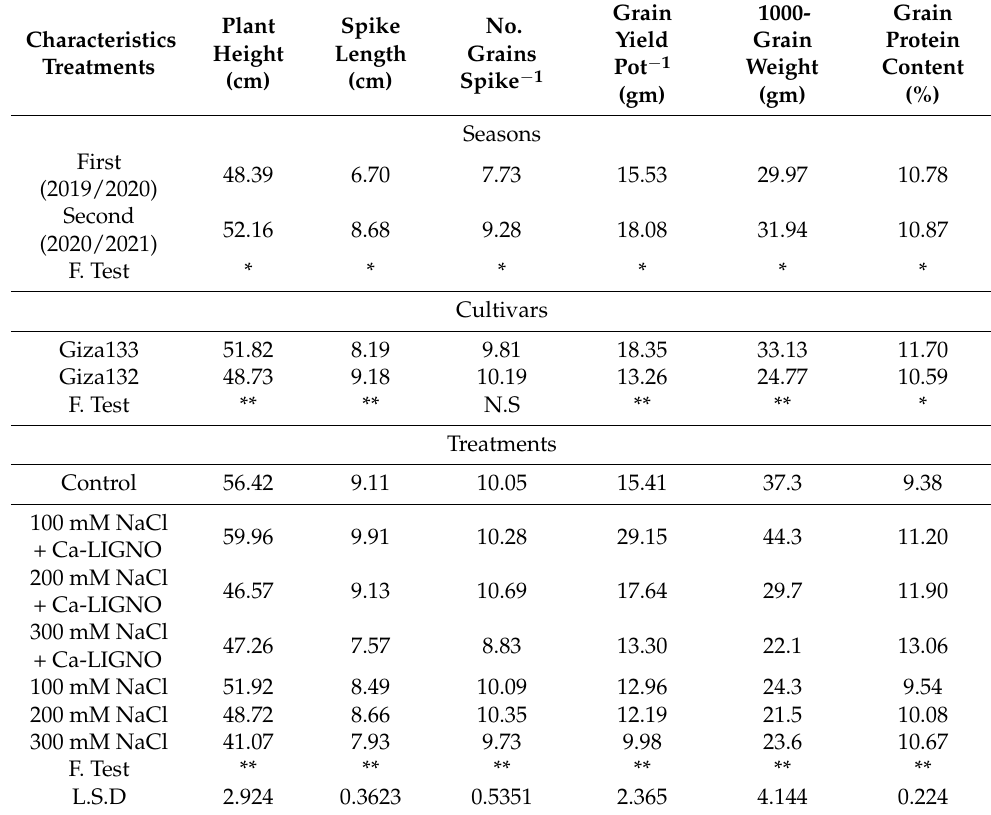
Table 4. Means of plant height, spike length, number of grains spike − 1 , grain yield pot − 1 , 1000-grain weight, and grain protein content of Giza133 and Giza132 barley cultivars under different treatments (control, NaCl concentrations, and NaCl concentrations + Ca-LIGNO) during, two seasons 2019/2020 and